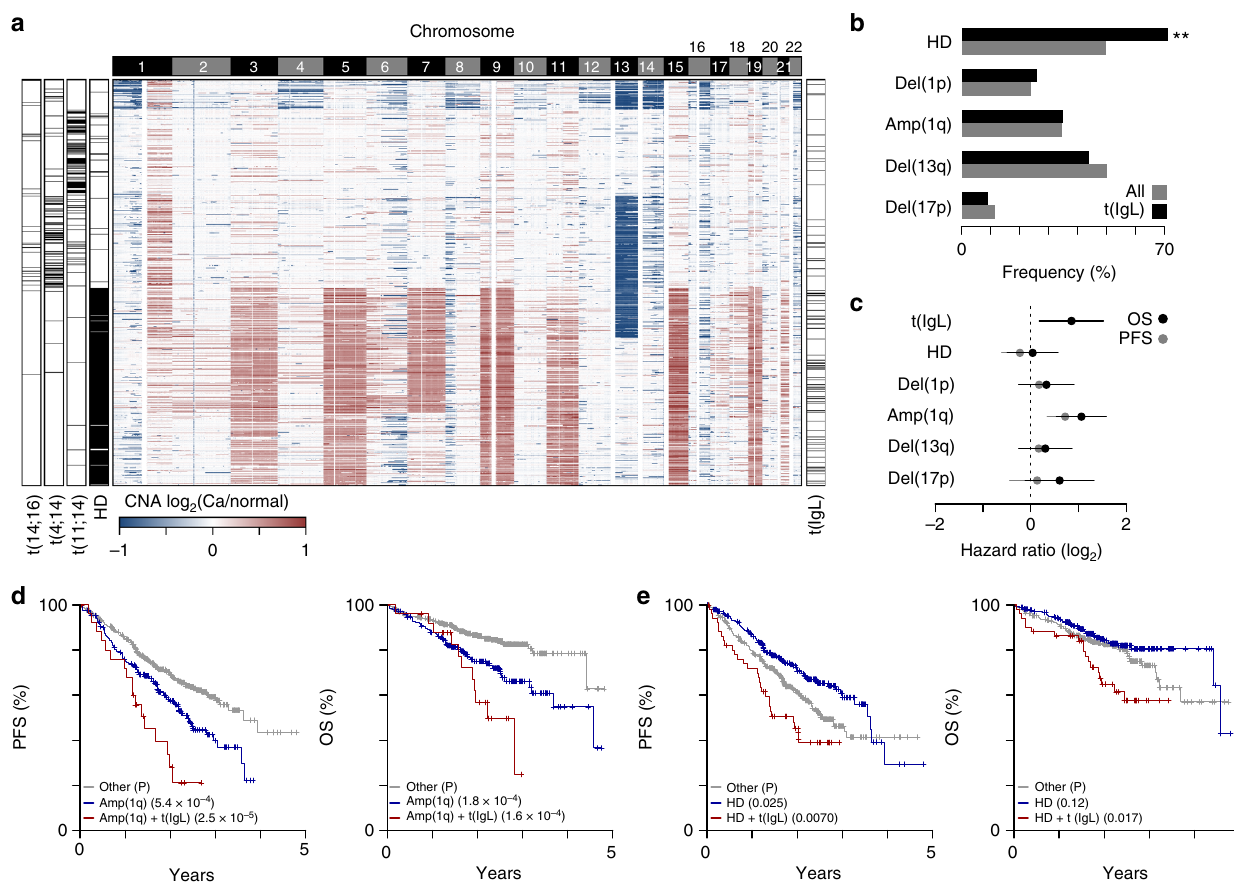
Fig. 6 IgL translocation co-occurs with hyperdiploid disease. a Heatmap of copy number alterations (CNA) in 777 newly diagnosed myelomas (rows) with genomic location (columns; 100 kb bins) labelled by chromosome (top). Hyperdiploid (HD) disease, and t(11;14), t(4;14), and t(14;16) translocations are annotated (left) as well as t(IgL) (right). b Frequency of common CNA in all newly diagnosed myeloma (gray) and myelomas with t(IgL) (black). ** P < 0.01, Fisher ’ s exact test. c Progression-free (PFS; gray) and overall survival (OS; black) hazard ratios determined by multivariate survival analysis of common CNA and t(IgL) with 95% con fi dence intervals shown. d Kaplan-Meier survival analysis of patients with ampli fi cation of 1q [amp(1q)] (blue), without amp (1q) (gray), or both amp(1q) and t(IgL) (red). e Same as part d except shown for HD. P -values denote the survival difference between the speci fi ed CNA (blue) and the CNA + t(IgL) (red) relative to the ‘ other ’ group as determined by a Cox proportional hazards Wald ’ s test. Source data are provided as